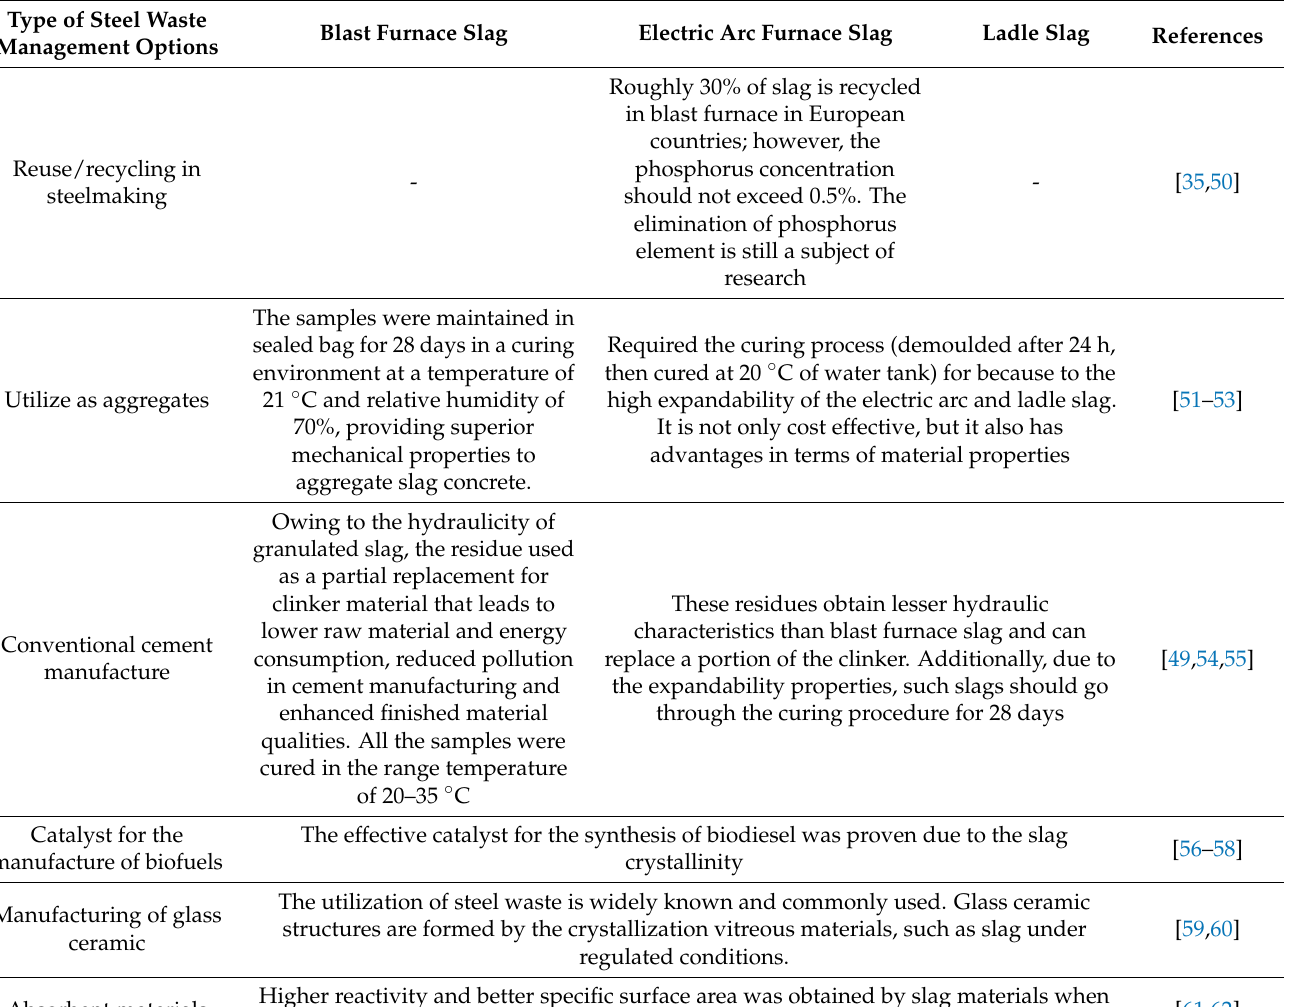
Table 4. Management options for steelmaking